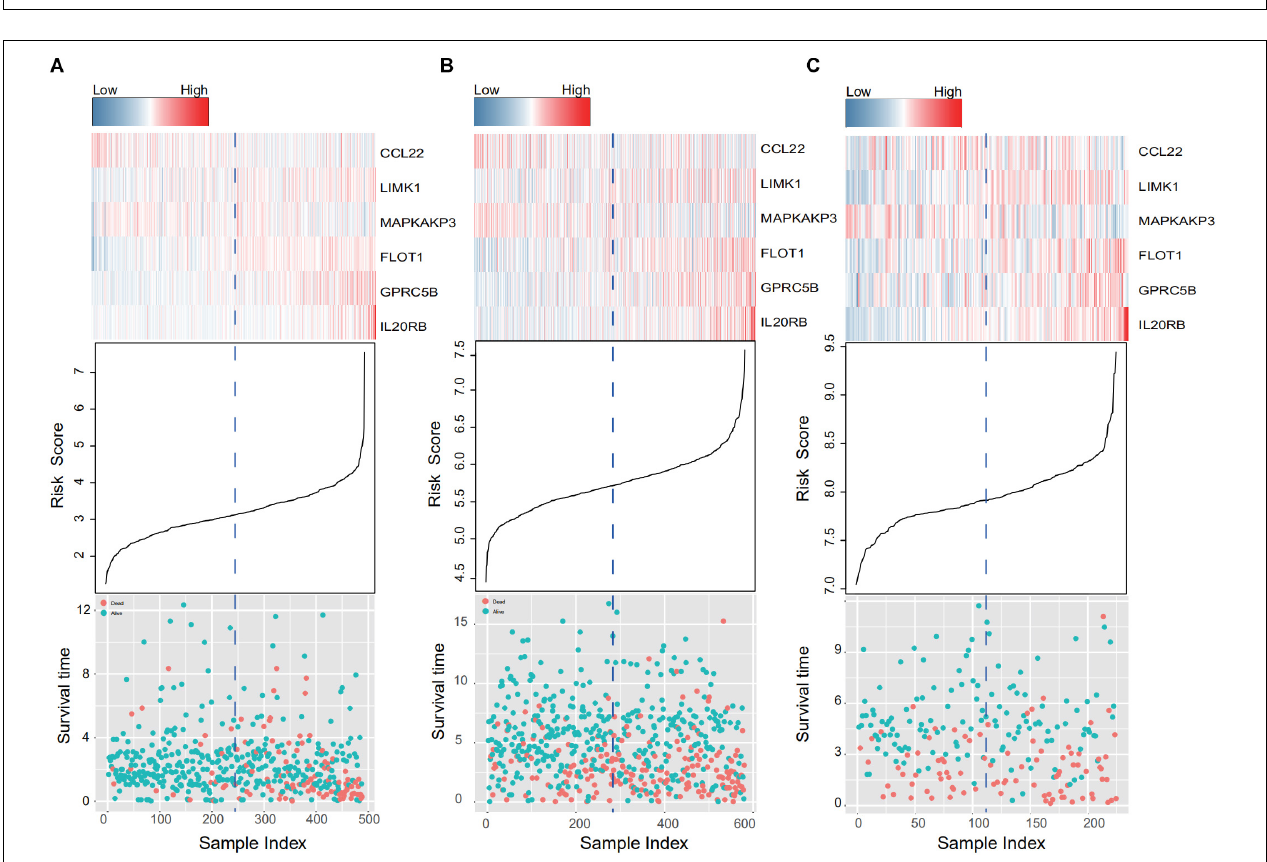
FIGURE 4 | IRG expression and survival information in the training and validation data sets. (A–C) Present the TCGA, GSE39582, and GSE17538 database results, respectively. Patients were queued according to their risk scores. Clusters in gene expression level and survival information in the training and validation groups are given. In high-risk populations, genes with adverse prognostic effects, namely LIMK1, FLOT1, GPRC5B, and IL20RB, showed consistent elevation in expression.